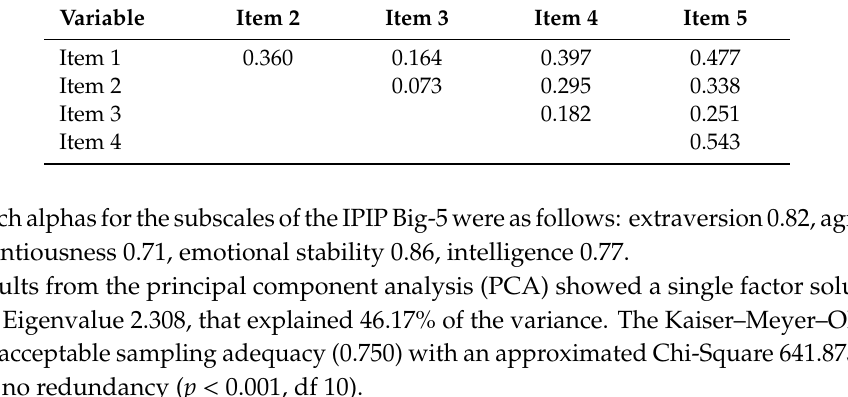
Table 2. Inter-item correlations of the items of the Croatian rMEQ ( n = 712).